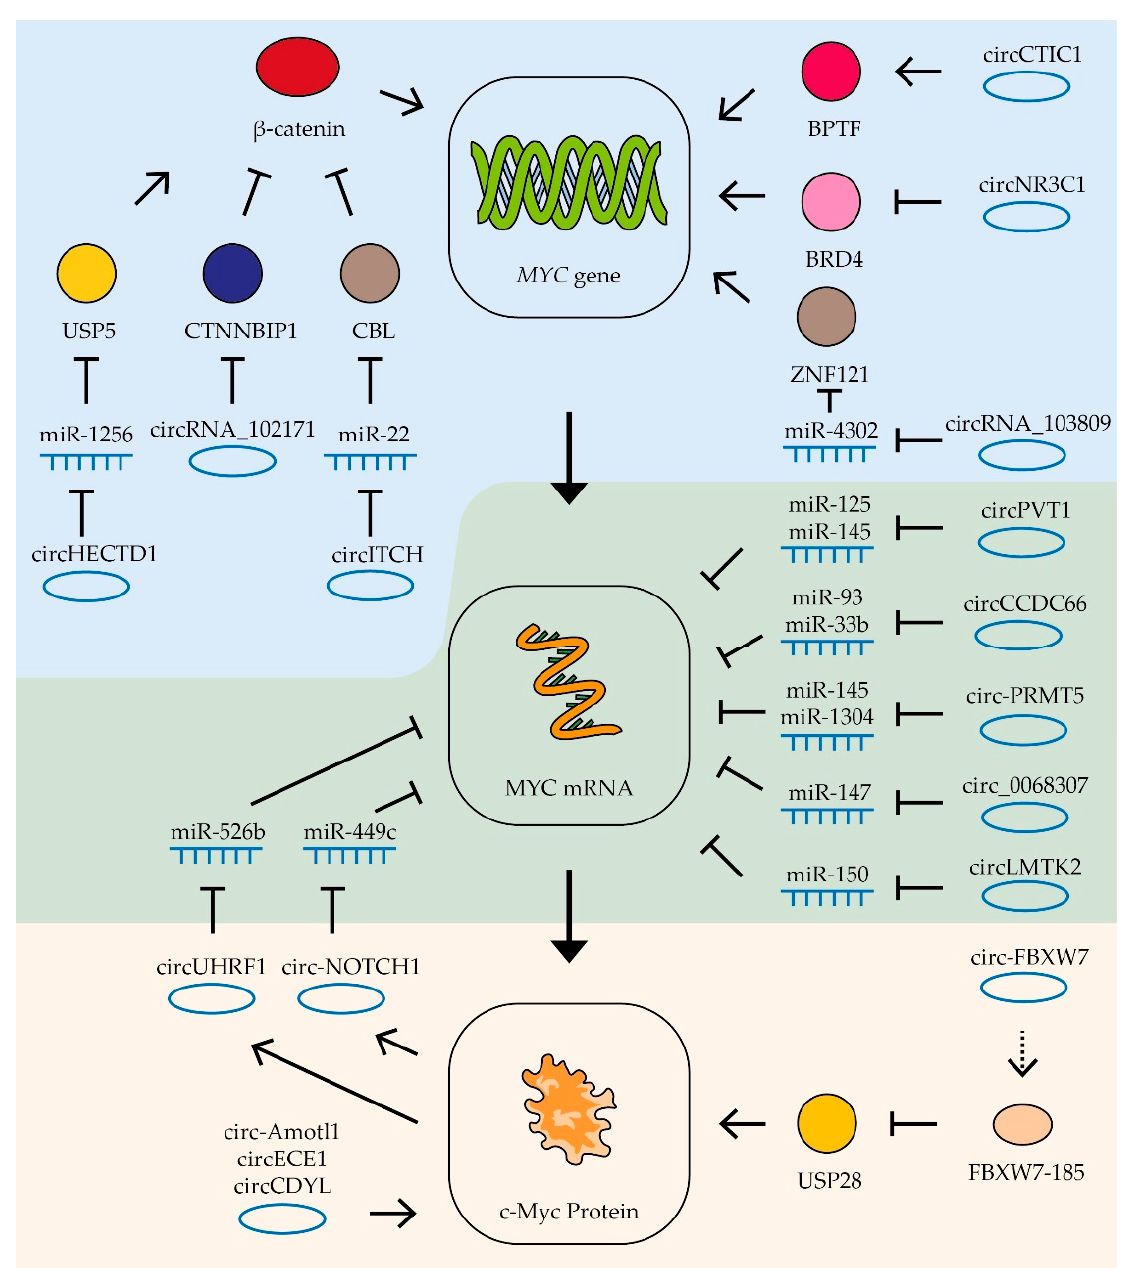
Figure 5. Control of MYC mRNA by circRNAs. Schematic representation of lncRNAs’ influence on MYC gene transcription (blue zone), MYC mRNA (green zone), and c-Myc protein stability (yellow zone). Colored circles indicate the proteins included in the pathway, the dotted line is a translation product. See text for description and references.